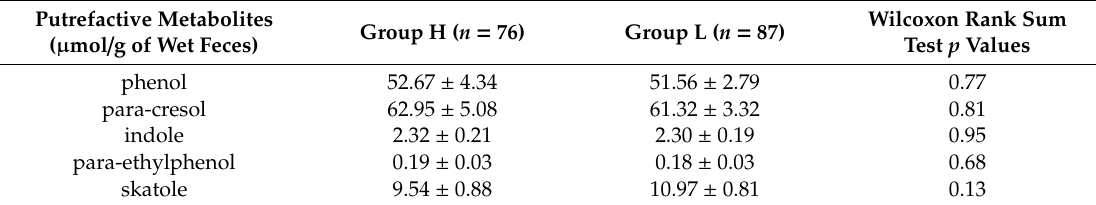
Table 5. Putrefactive metabolites concentrations in fecal samples of high- and low-reproductive performance